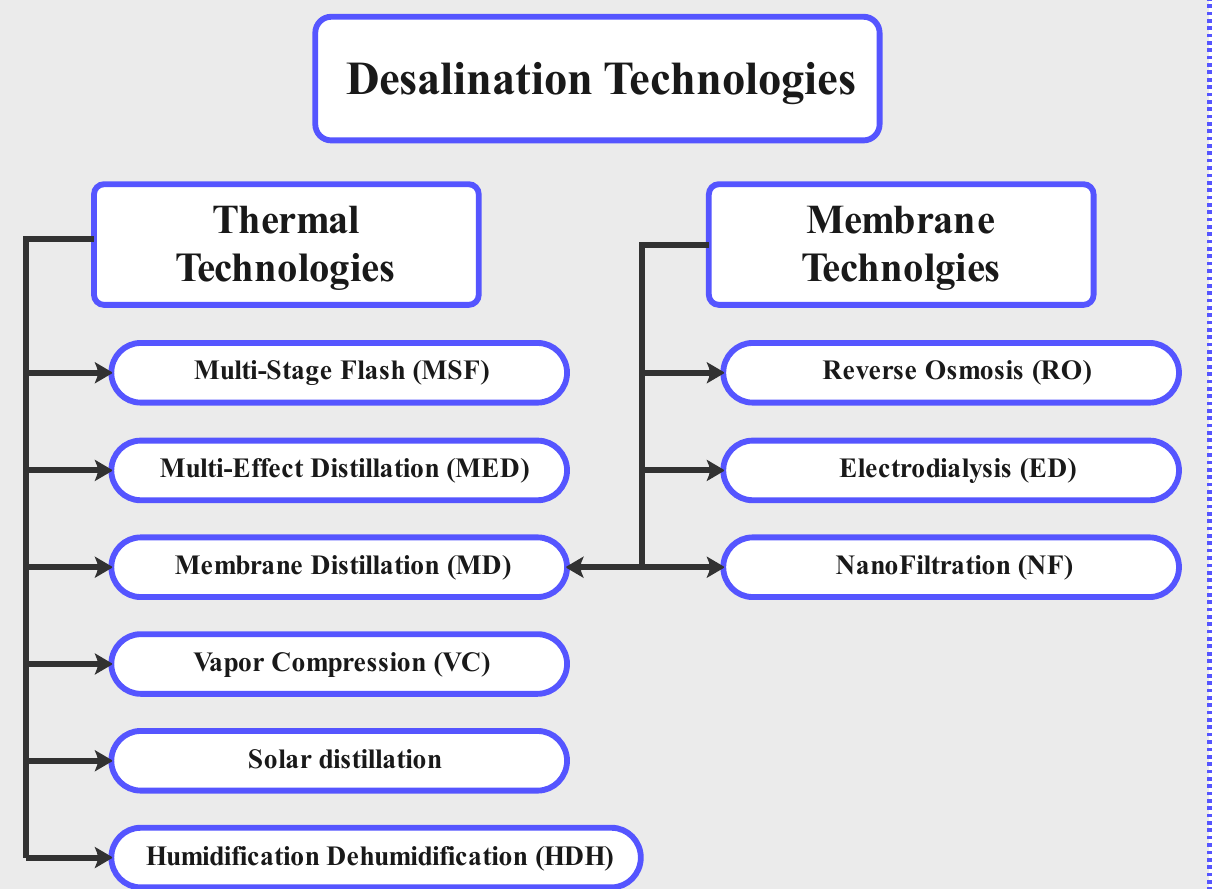
Figure 1. Main solar cooling technologies.